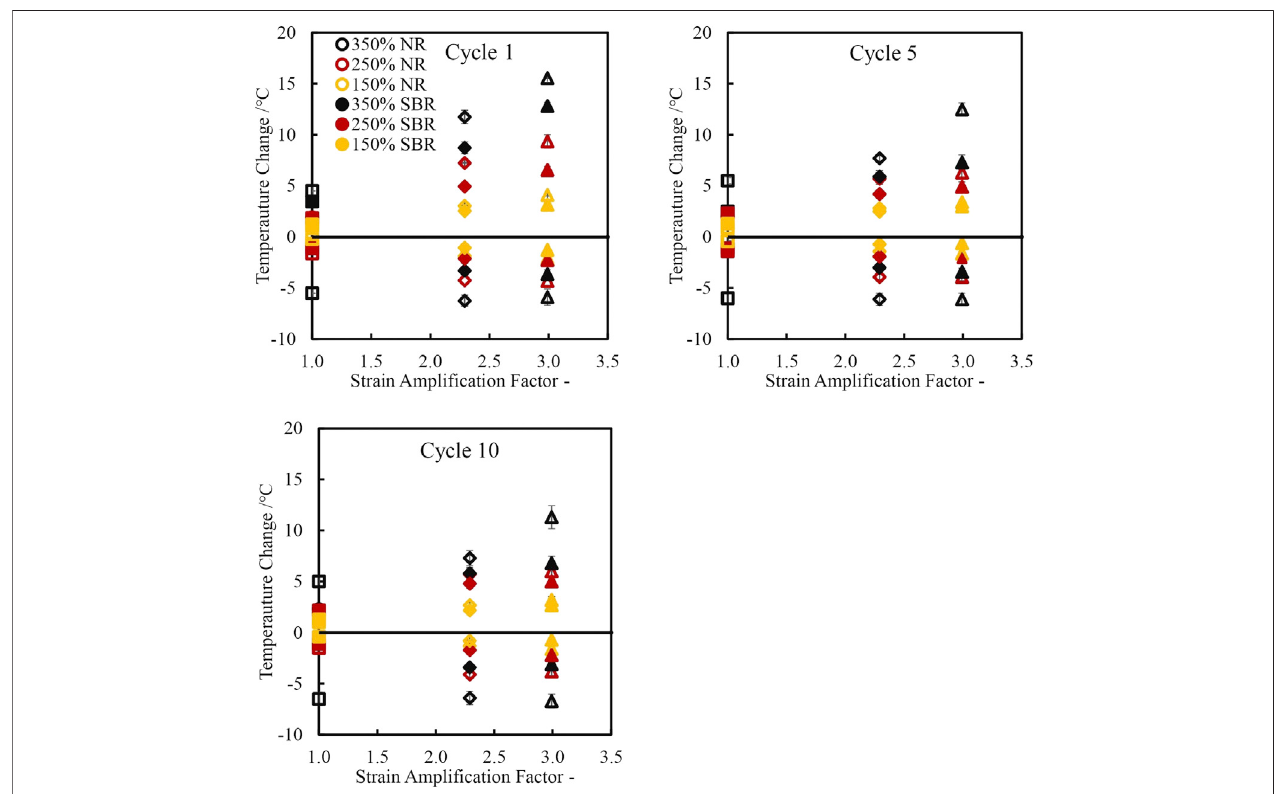
FIGURE 13 | Temperature change as a function of strain ampli fi cation factor comparing SBR ( fi lled shapes) and NR (un fi lled shapes) extended to 350% (black), 250% (red) and 150% (yellow) and retracted after 2 min.